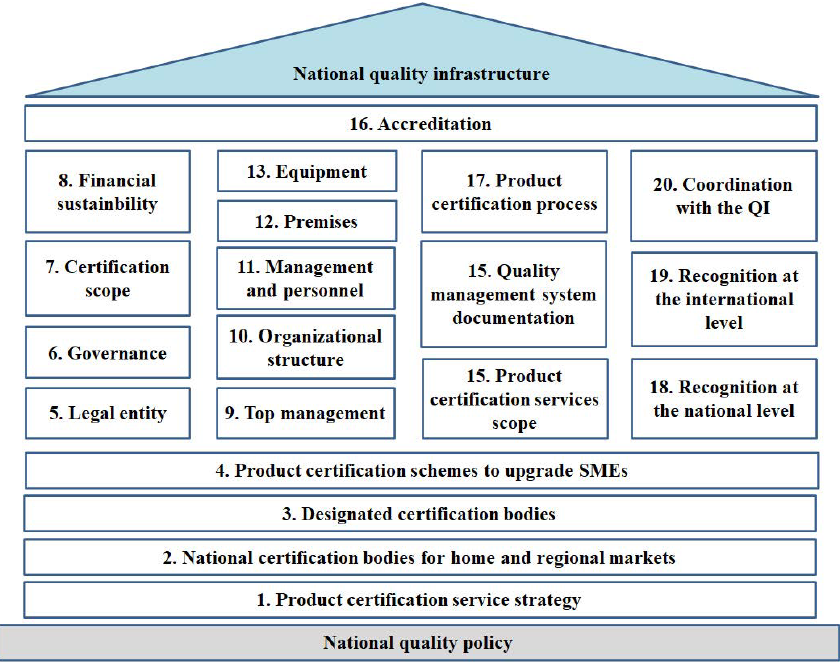
Figure 3: Overview of pillars and building blocks of product certification for national quality infrastructure [14]